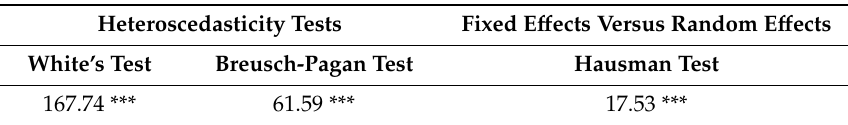
Table 5. Panel data model specification